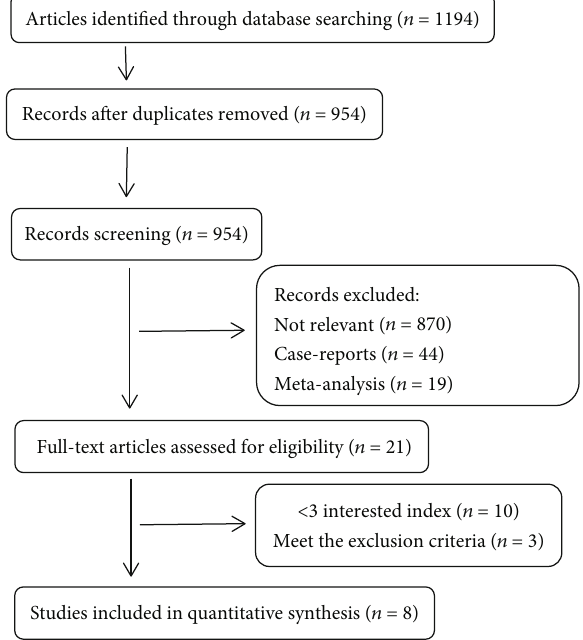
Figure 1: Flow diagram of the study selection process for meta-